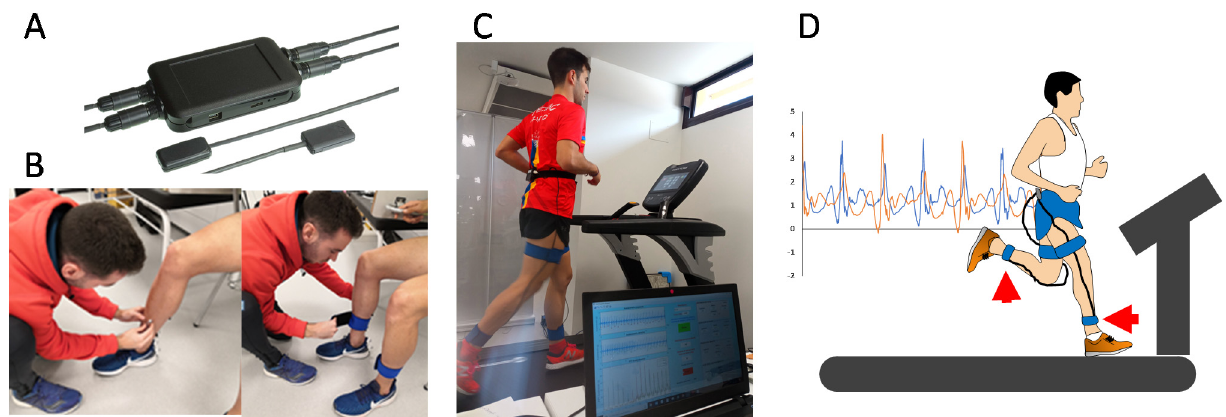
Figure 1. Graphical schematic of the body-worn accelerometer fixed to athletes: ( A ) Accelerometry system (AcelSystem, Blautic); ( B ) accelerometer fixation on distal and anteromedial portion of each tibia; ( C ) final experimental setup; and ( D ) graphical representation of the accelerometer signal and the experimental setup.